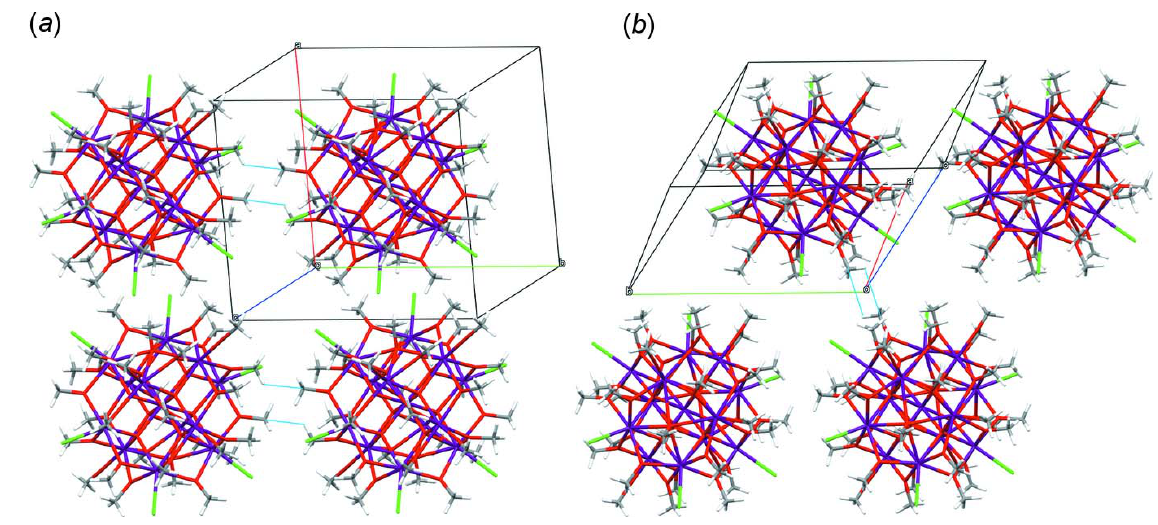
Figure 4 Packing diagrams of I . Light-blue lines indicate the intermolecular short contacts [( a ) SC1 and ( b ) SC2] between hydrogens and carbons of adjacent methoxide groups. The structure is drawn as [U 13 ( (cid:2) 4 -O oxo ) 8 Cl 6 (MeO) 32 ] in order to omit the disorder between chloride and methoxide anions for clarity